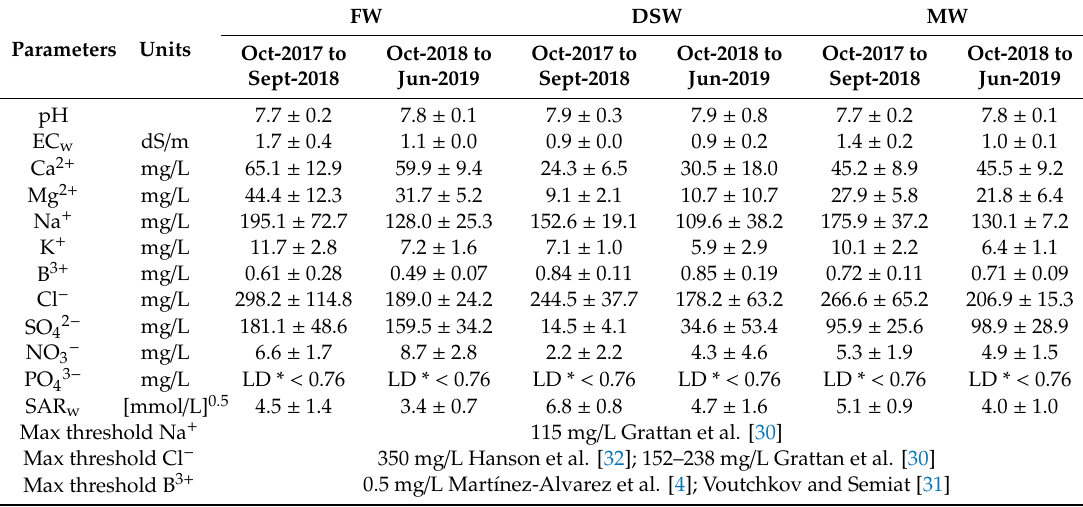
Table 1. Chemical properties (electrical conductivity: EC w , Sodium adsorptium ratio: SAR w , pH, cations: Na + , K + , Ca 2 + , Mg 2 + , B 3 + and anions: Cl − , NO 3 − , PO 43 − , and SO 42 − ) for fresh water (FW), desalinated seawater (DSW), and mixed water (MW). Data are divided into the two main periods of the study.